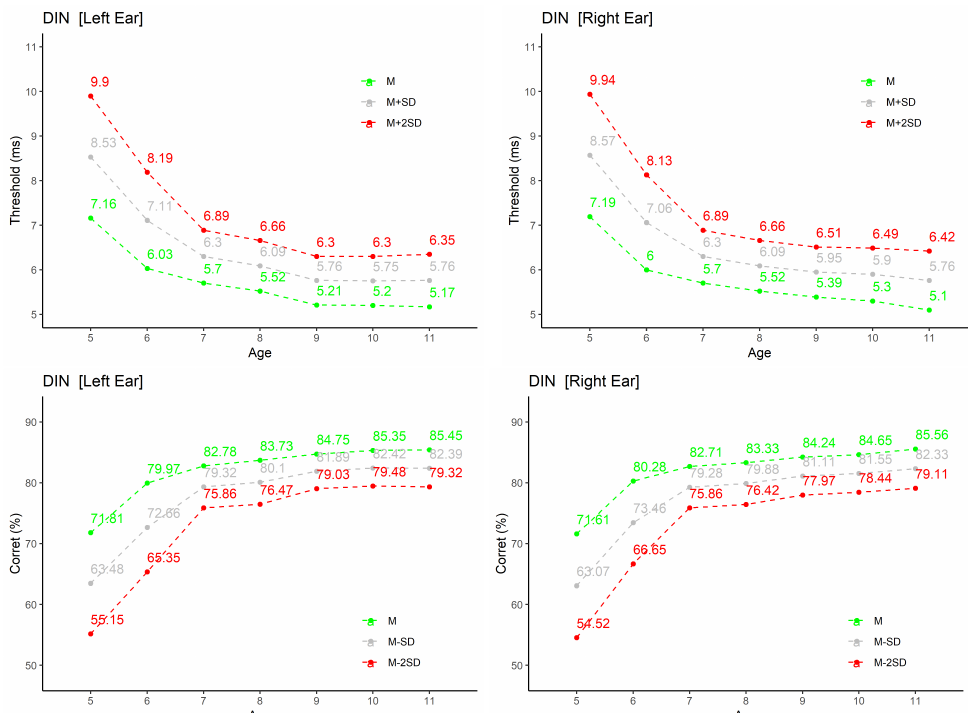
Figure 6. Results for Detection of Interval in Noise test: top row presents the hearing thresholds (in ms) by age group and ear; bottom row the percentage of correct answers also by age group and ear. In addition to the average value (M), M + 1SD and M + 2SD are shown for the threshold and M − 1SD and M − 2SD for correct